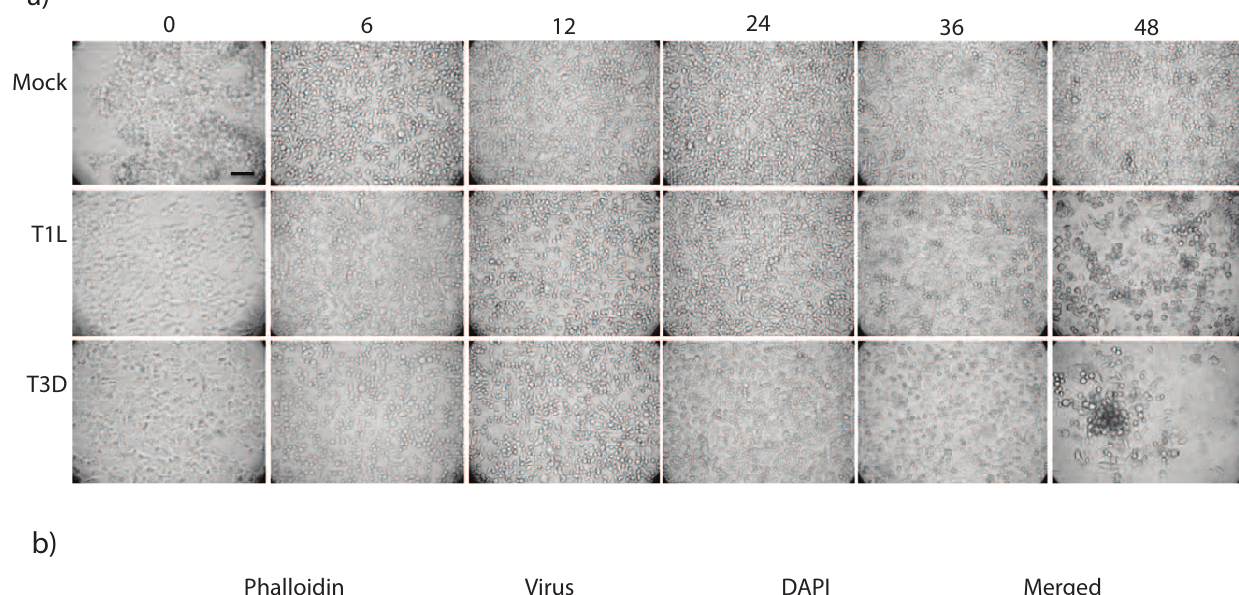
Figure 2. Microscopic evaluation of HEK293 cells infected with reovirus at MOI 5. (a) photomicrographs of 293 cells mock-infected (top row), or infected with T1L (middle row) or T3D (bottom row) for various times (indicated at top). Scale bar =40 m m. (b) HEK293 cells were infected with MRV strain T1L at MOI 5. Cells were stained for f-actin (red), reovirus (green), and DAPI (blue). At 8, 12, 18 and 24 hpi, 5.31%, 64.0%, 83.2% and 100% of cells were infected, respectively (indicated in upper rightmost corner of each image). Scale bar =40 m m.